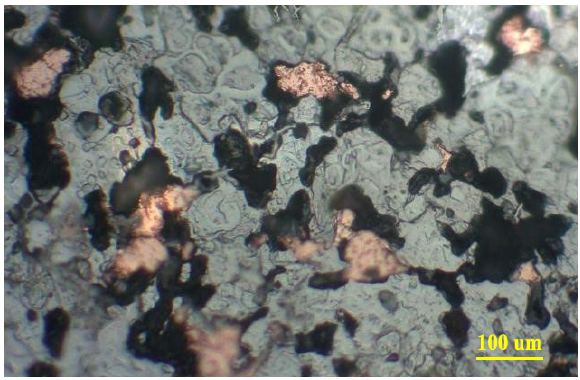
Figure 2. OM micrograph of sample 1.